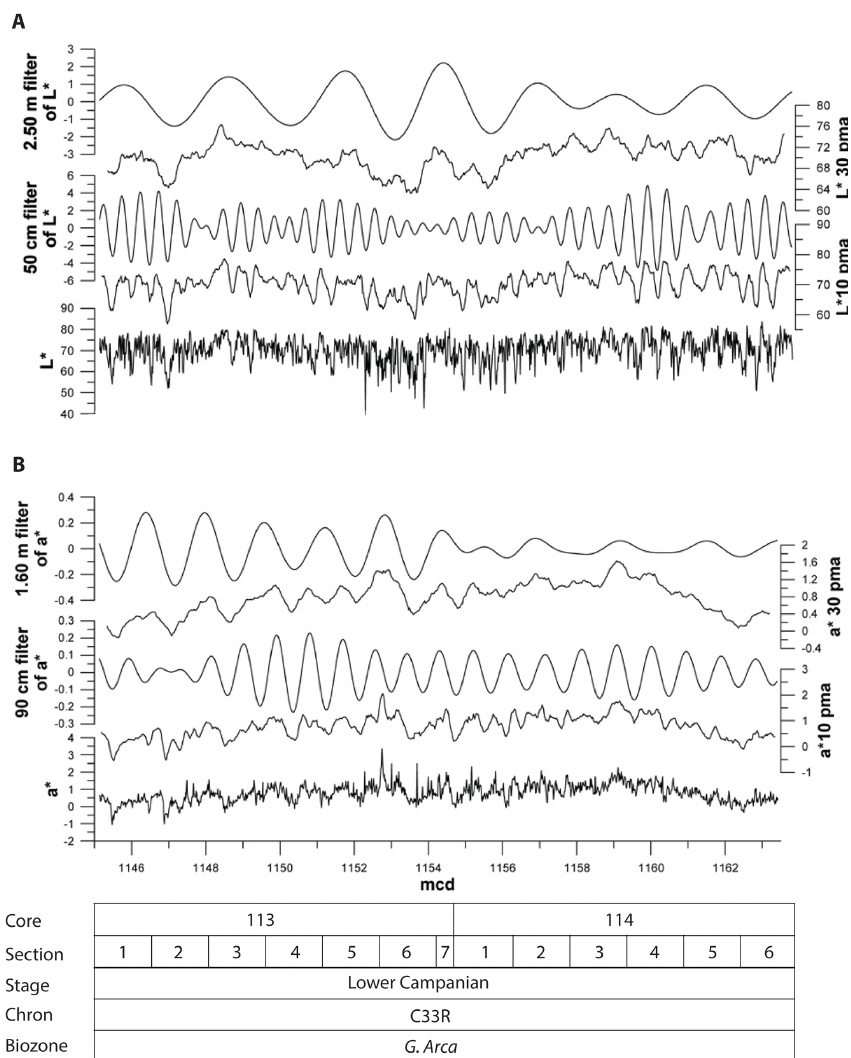
Figure 1. Pma’s of L ∗ with filters of presumed precession (0.50m ± 0.09m) and eccentricity (2.64m ± 0.84m) wavelengths (A) and a ∗ with filters of presumed obliquity (0.93m ± 0.13m) and double obliquity (1.73m ± 0.45m) wavelengths (B) . The panel below shows the stratigraphic position of the studied interval and which core sections were